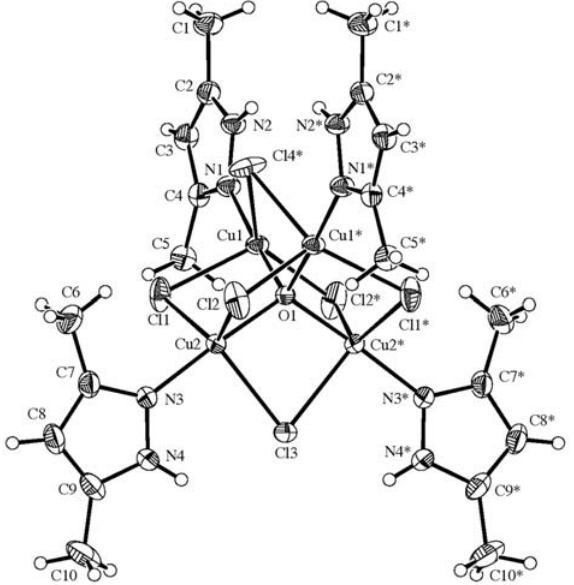
] molecule, clu- Cl O(C H N ) 4 6 5 8 2 4